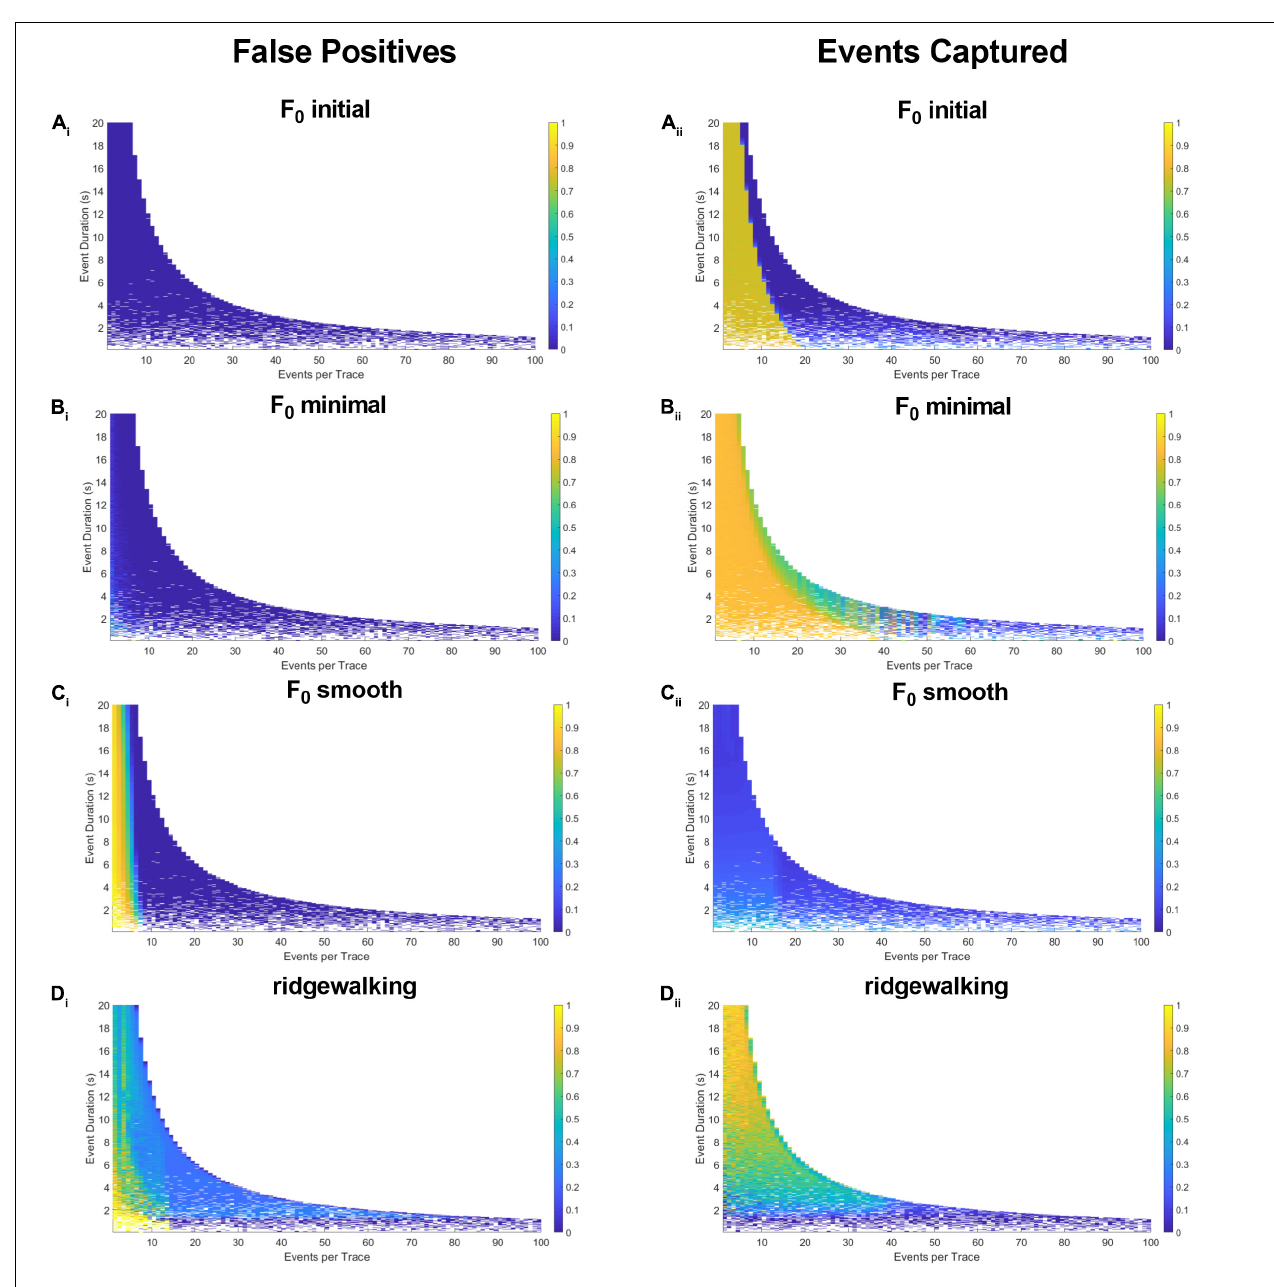
FIGURE 5 | Synthetic data for pseudoneuronal events with exponential decay. The left-hand plots represent “false positives” or the fraction of rasters existing outside of known event bounds, and the right-hand plots represent the “events captured” or the fraction of total event bounds that are covered by the rasters. (A i , ii ) Results for F 0 initial thresholded at 2.5 baseline standard deviations. (B i , ii ) Results for F 0 minimal thresholded at 2.5 baseline standard deviations. (C i , ii ) Results for F 0 smooth thresholded at 2.5 baseline standard deviations. (D i , ii ) Results for wavelet ridgewalking